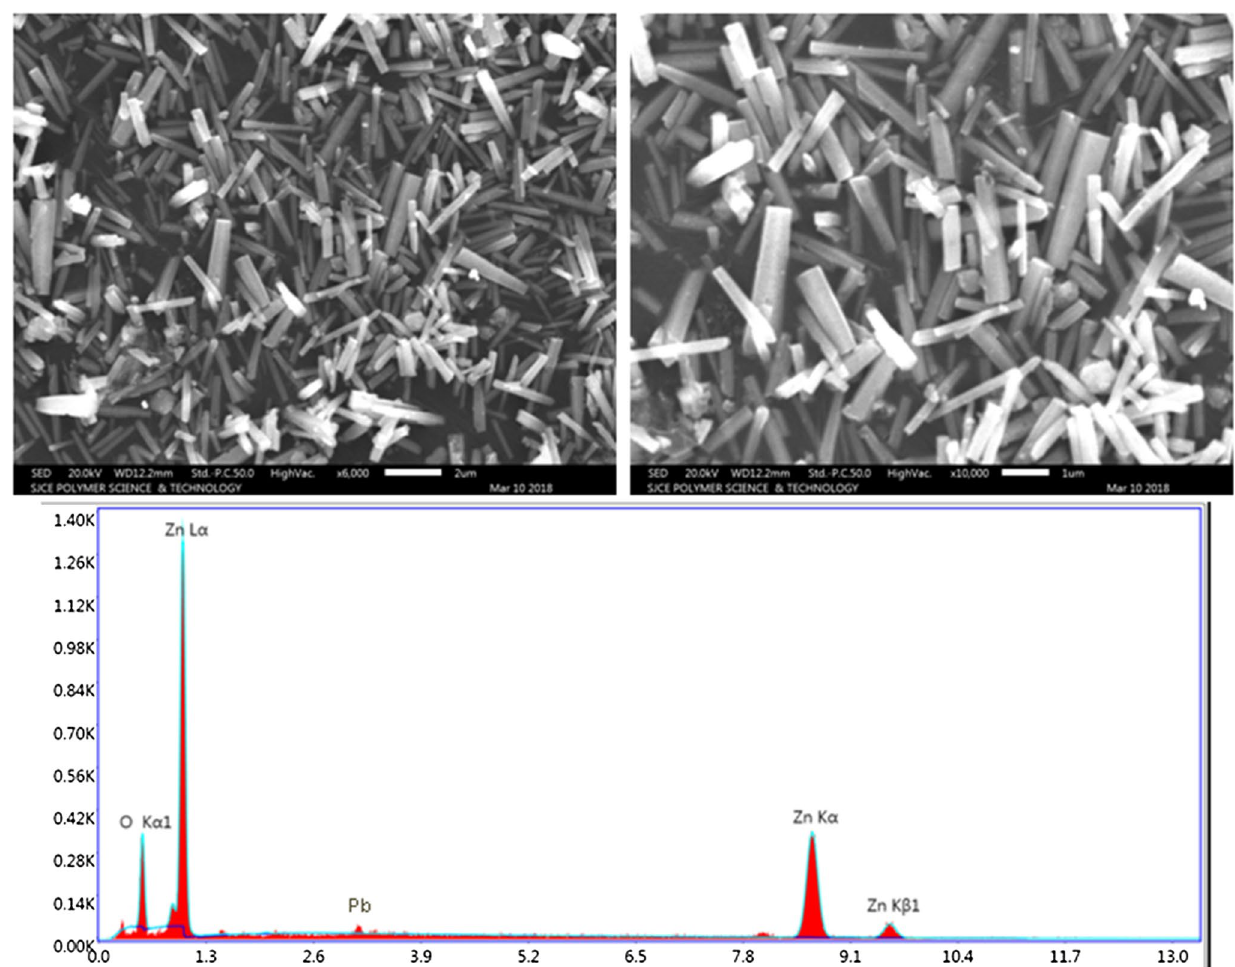
Fig. 5 Scanning electron microscopic images with energy-dispersive X-ray analysis of Pb/ZnO nanoparticles